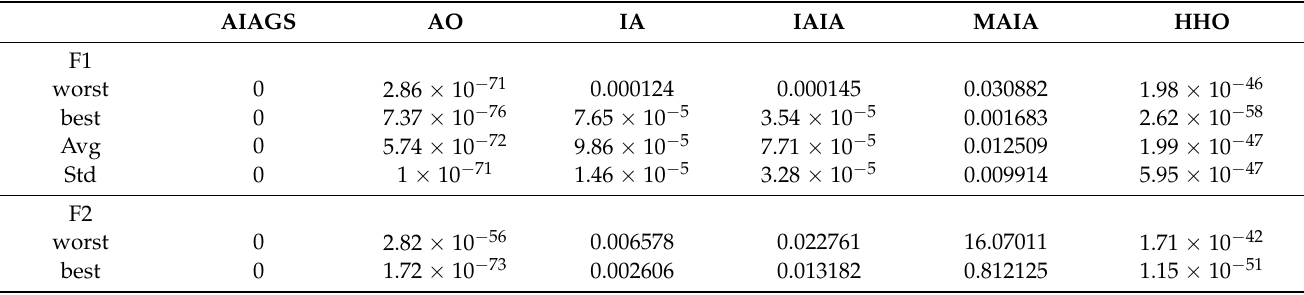
Table 3. Comparison of results obtained for the benchmark